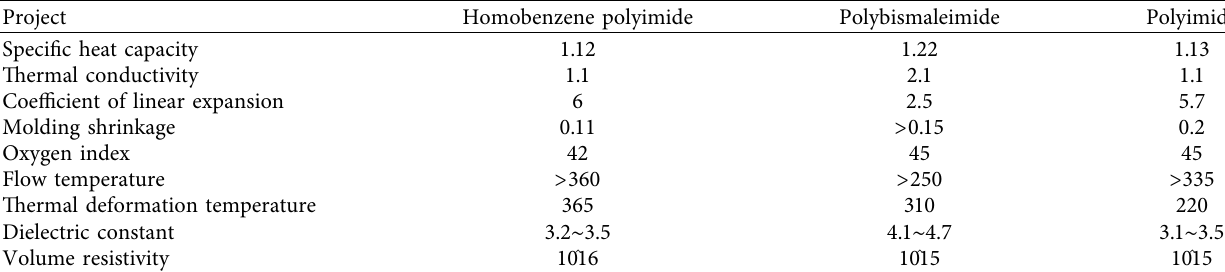
Figure 4: Geomagnetic field analog shielding hardware system. Table 4: Physicochemical parameters of